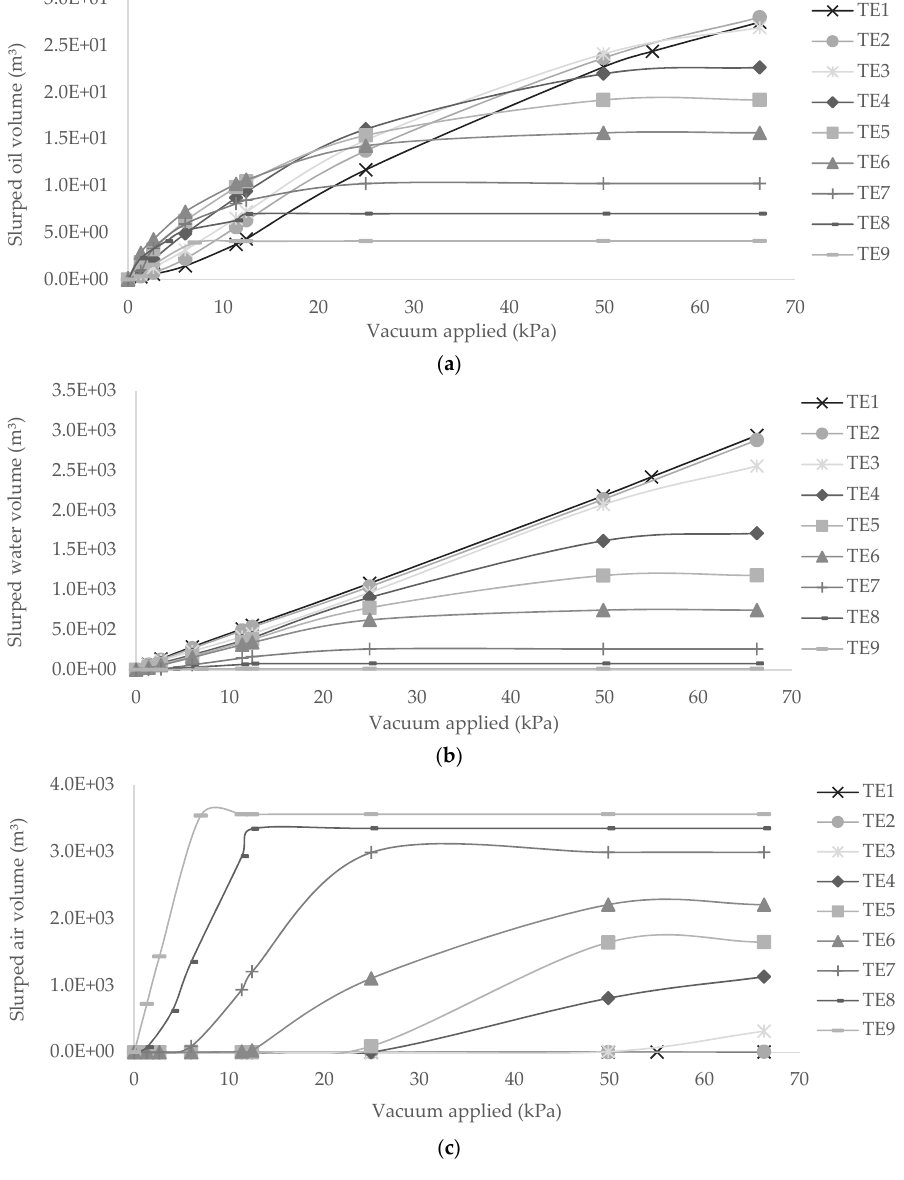
Figure 5. Slurped volume oil ( a ), water ( b ), and air ( c ) for 100 days as a function of vacuum pressure for extraction depending of the slurping tip tube positions z (TE1 = 6.85, TE2 = 7.05, TE3 = 7.25, TE4 = 7.55, TE5 = 7.75, TE6 = 7.95, and TE7 = 8.25 m) located in water (TE1), oil–water interface (TE2), oil (TE3, TE4, TE5, TE6, and TE7), air–oil interface (TE8), and air (TE9) in oxisol.